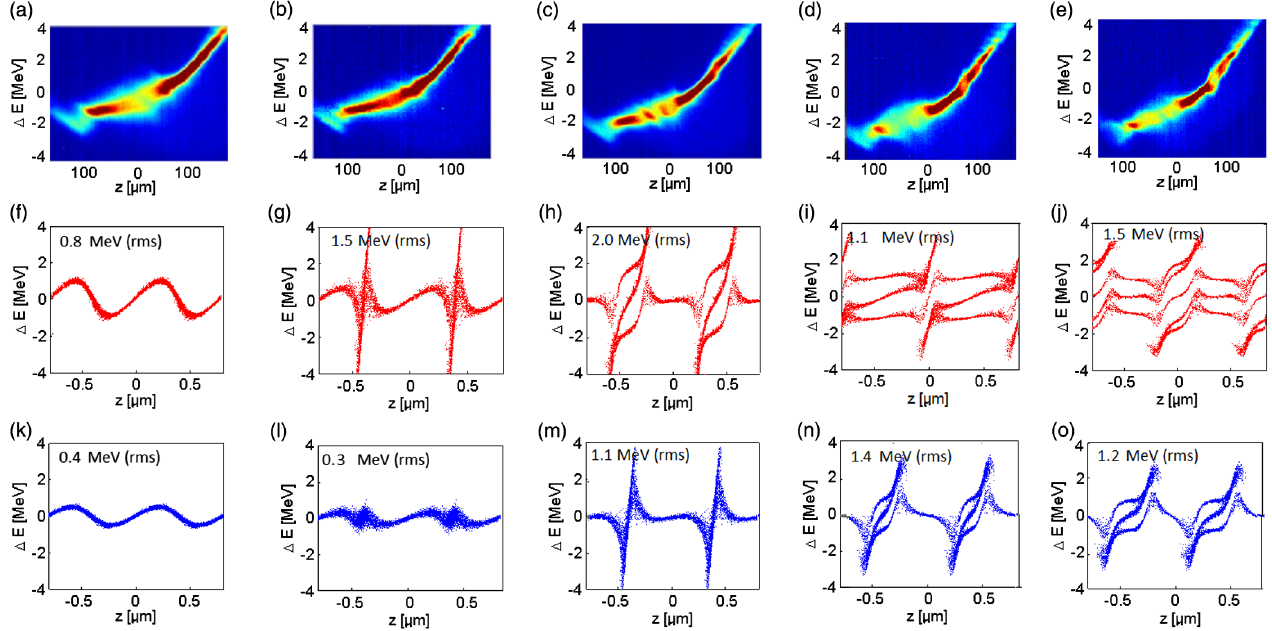
FIG. 4. Measured longitudinal phase-space distribution of a seeded electron beam under the influence of Coulomb forces for uncompressed η ¼ 20 μ m (a), undercompressed, η ¼ 50 μ m (b), fully-compressed, η ¼ 100 μ m (c) and overcompressed η ¼ 200 – 250 μ m (d – e) microbunches. The color code corresponds to the number of electrons hitting the camera ’ s pixels and is described in the text. Simulated longitudinal phase space distribution of microbunches after the 25 m drift for the conditions described in (a) – (e) are below each measurement. Rows (f) – (j) correspond to the conditions at the center of the seeded region with an initial energy modulation of 1.3 MeV (rms) and an initial peak current of 300 A. Rows (k) – (o) corresponds to the conditions at a distance of σ from the center of the seed with an initial energy modulation of 0.65 MeV (rms). The beam energy was 700 MeV with an average radius of 135 μ m in the drift space. The head of the bunch is to the left and the peak current drops from 300 A to 250 A along the seeded portion. The emittance in the simulations is 1 mm mrad and the slice energy spread was 70 keV